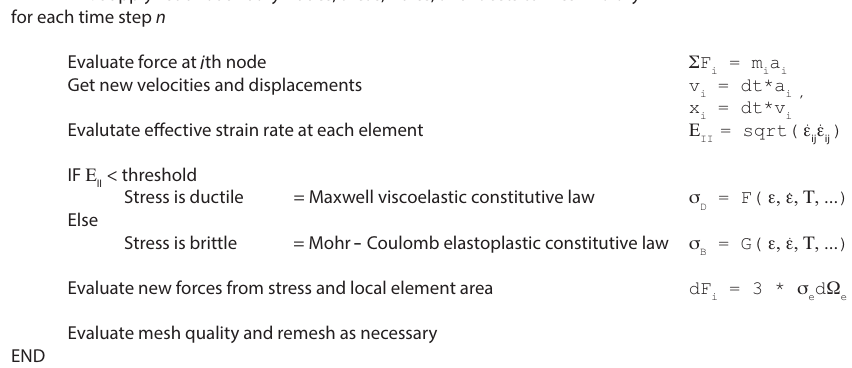
Figure 1. Schematic of one time step in